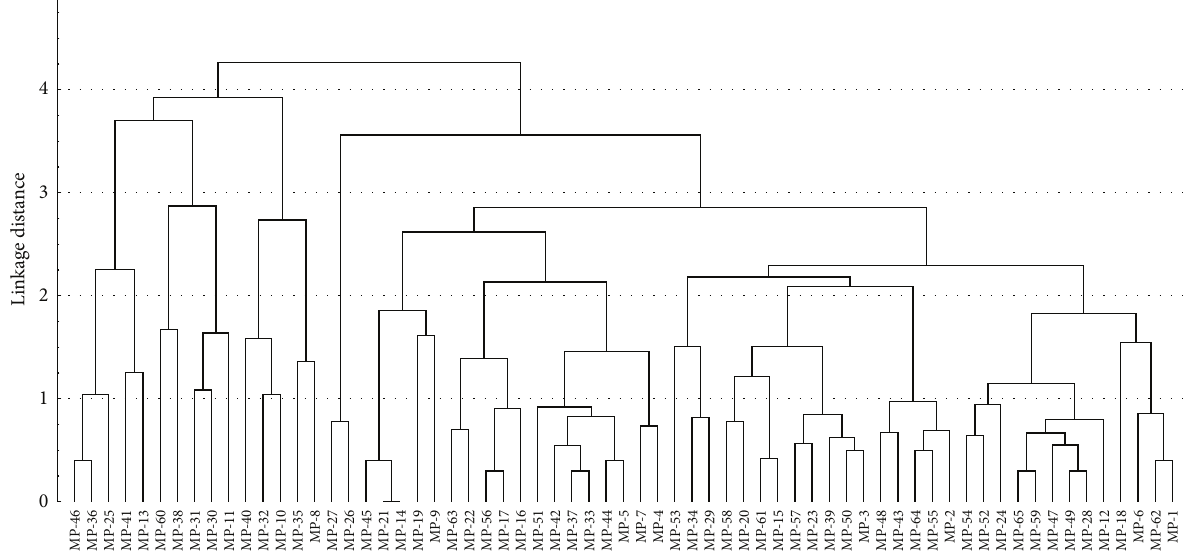
Figure 2: Dendrogram showing the clustering of the virulence of M. phaseolina isolates on 3 mungbean cultivars.